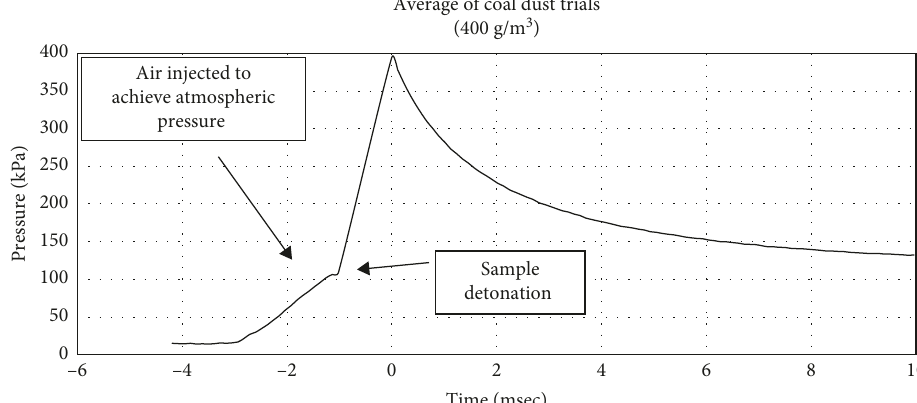
Figure 5: Idealized coal dust test.